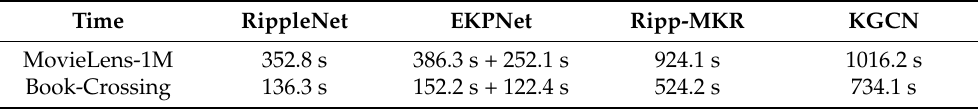
Table 5. The cost of the